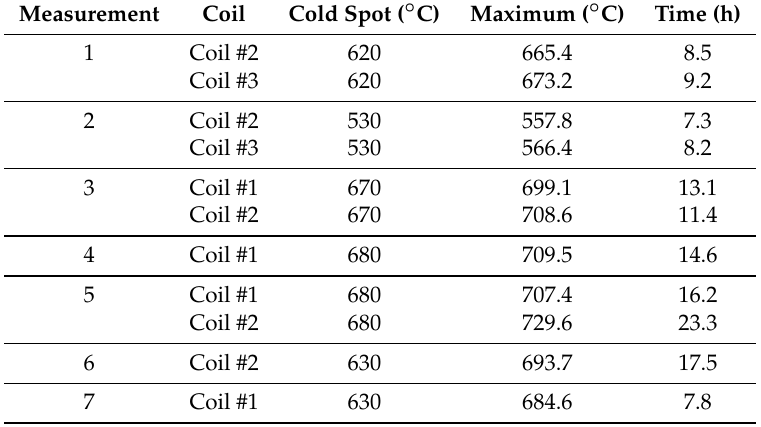
Table 4. The time from cold spot temperature reach to holding time ending for operating